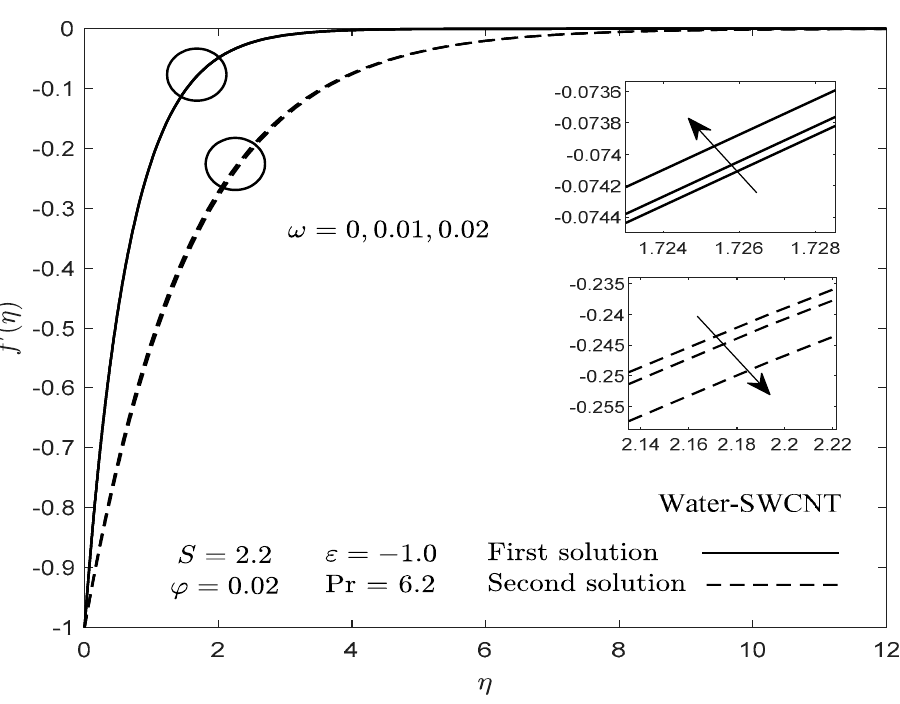
Figure 6. Values of −𝜃′(0) for some values of 𝜑 versus 𝑆 .